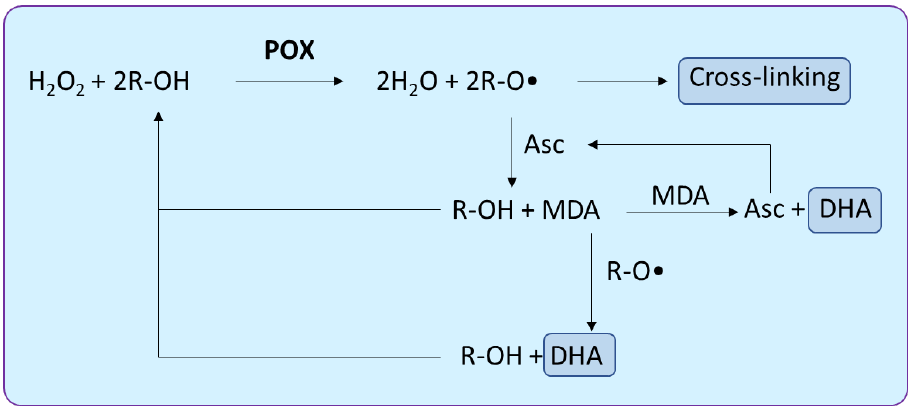
Figure 2. Reaction catalysed by peroxidase (POX) and cascading events; R = any phenolic compound, Asc = Ascorbate, MDA = Mono-dehydro-ascorbyl radical, DHA = de-hydro-ascorbate. When compared with the antioxidant activity of different enzymes under HM treatment, it was found that SOD and CAT activity were inhibited at high dose treatment of arsenite (AsIII) and arsenate (AsV) in Lemna valdiviana , while POX activity remained unchanged under increasing concentration of these HM treatments, which indicates that some of the antioxidant enzymes remain functional [84]. The importance of having different enzymes, employed by the plant to cope with the stress conditions, is highlighted in that study. Furthermore, stress memory in plants plays an important role. To understand the correlation between the stress memory and activity of POX (among other antioxidant enzymes), Alopecurus pratensis was given intermittent drought treatment, and it was found that drought memory is linked to higher levels of antioxidative enzymes, including POX, SOD and CAT [85]. Recently, a paper posted on a pre-print server (not peer reviewed) revealed 47 POX genes in the grapevine genome, classified into seven subgroups based on their phylogenetic analysis and GWAS approach [86]. After studying horseradish POX under in vitro conditions, three different reaction mechanisms catalysed by POX were proposed by Jovanovi´c et al. [87], i.e., Peroxidatic, oxidative and hydroxylic cycles, which are described in Figure